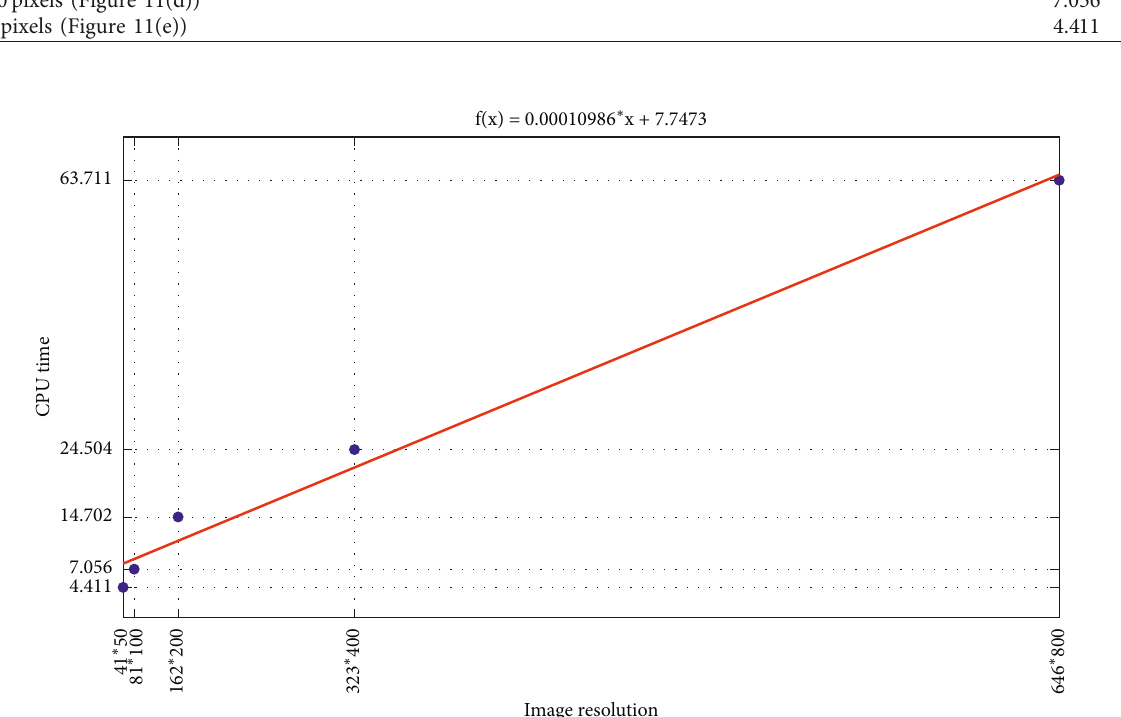
Figure 13: The fitted function curve generated by taking the data in Table 2 as